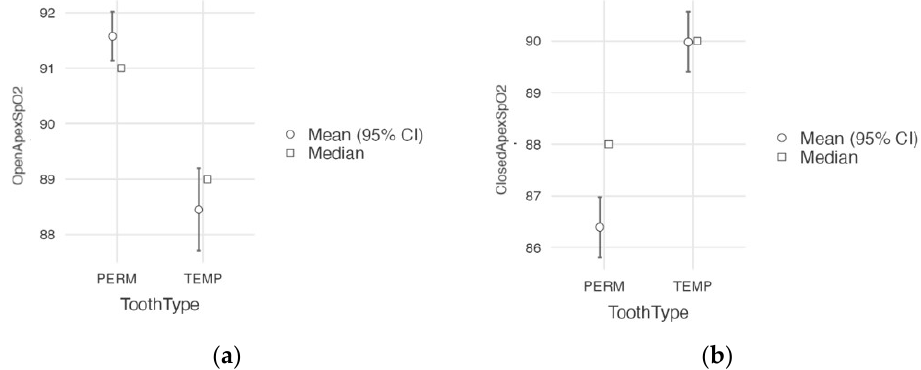
Figure 6. Graphic representations of SpO 2 measured in primary vs. permanent teeth with an open apex ( a ) and a closed apex ( b ).